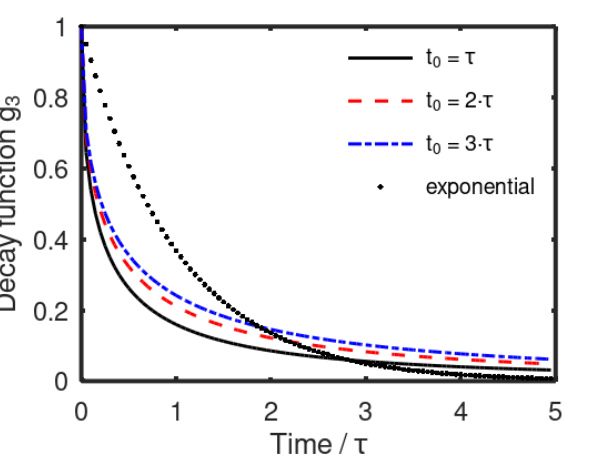
Figure 3. Decay function of the initial voltage obtained for a ZARC with α = 0.5 by applying a constant current (lines), for different values of t 0 , compared to the exponential decay function of a parallel RC element